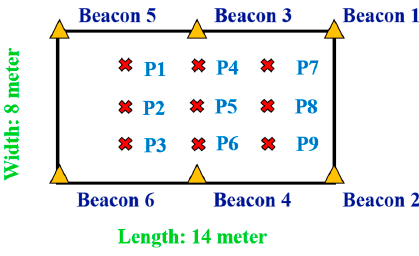
Figure 9. The testing field for the evaluation of beacon positioning. Table 3. The error analysis of bounding box: N and E represent the errors in meters corresponding to north and east directions; Red value indicates an error larger than 3 meters.